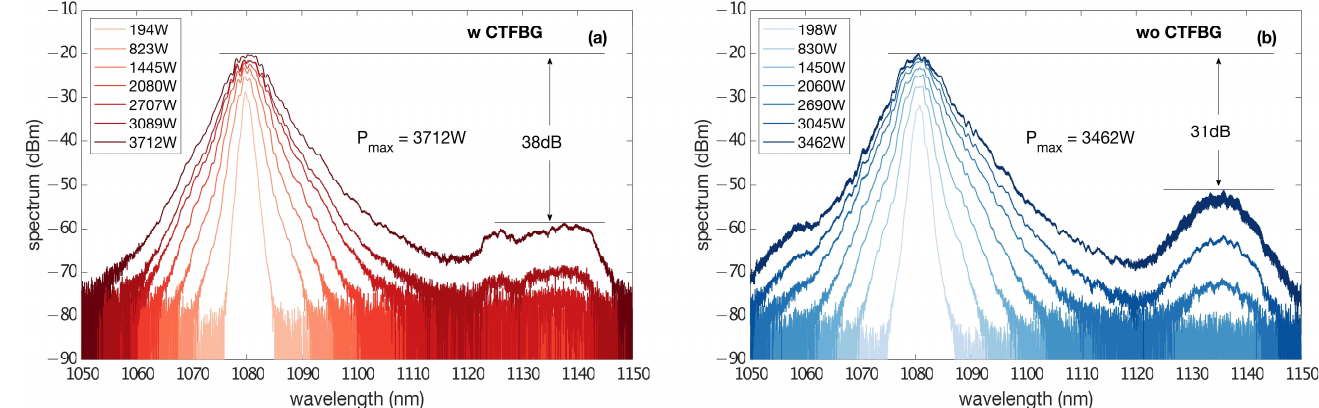
Figure 6. Spectra of the output laser at different powers ( a ) with or ( b ) without the CTFBG.